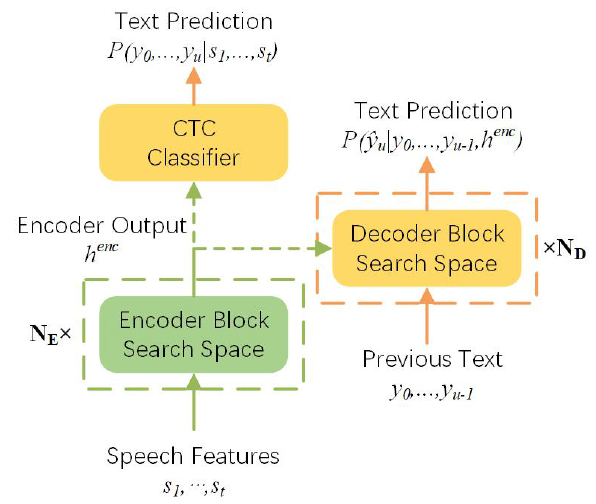
Figure 1. The backbone of our proposed search space. The encoder output can be fed into the CTC classifier or the decoder, and in this way, the search space can support the architecture search of the CTC and AED frameworks